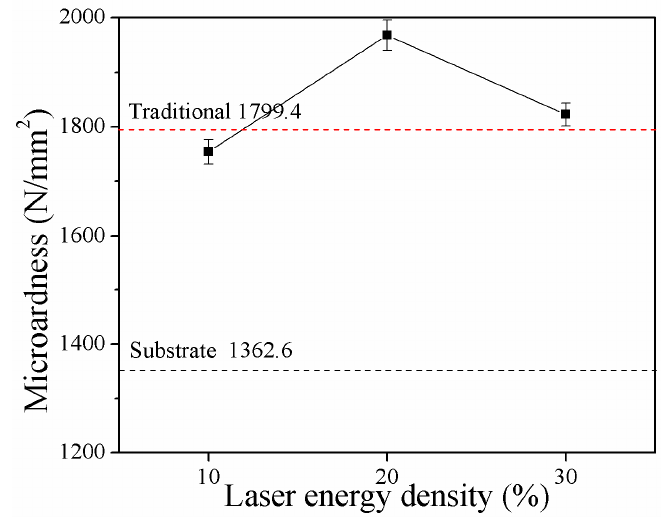
Figure 9. Hardness of the titanium alloy substrate and different pretreatment coatings.